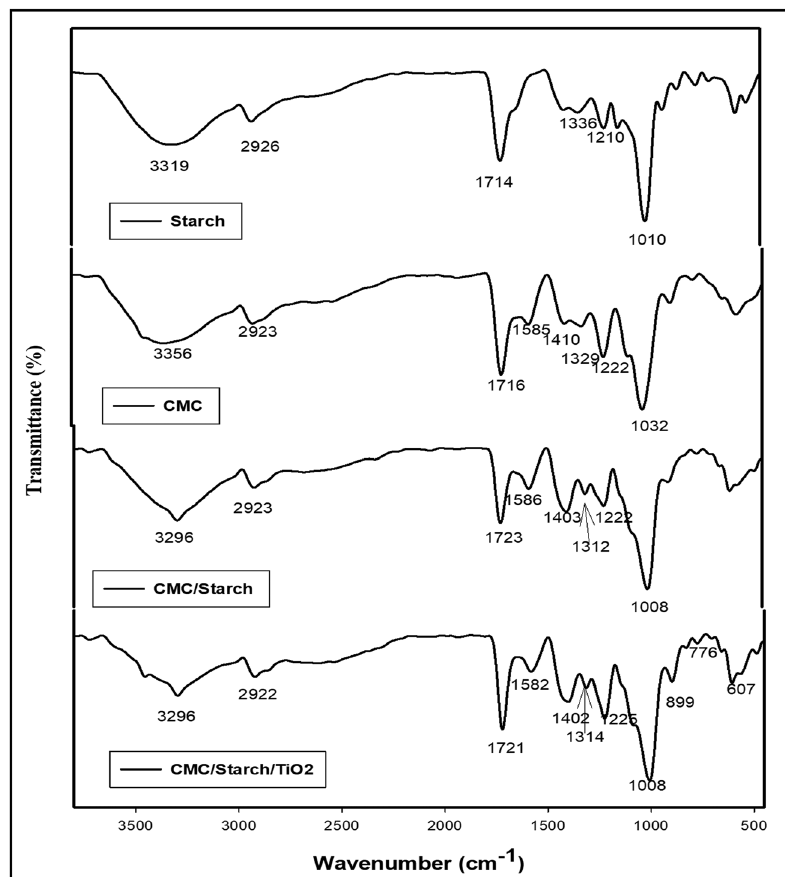
Figure 1: FT - IR spectra of pure starch, CMC, CMC/starch, and CMC/starch/TiO 2